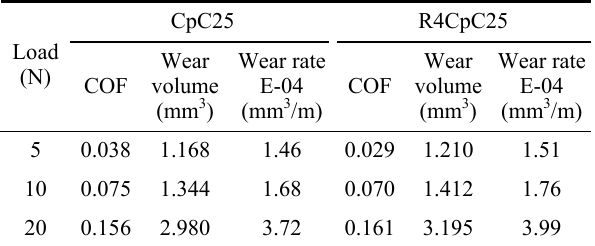
Table 4 Comparative data of the friction and wear tests of CpC25 and